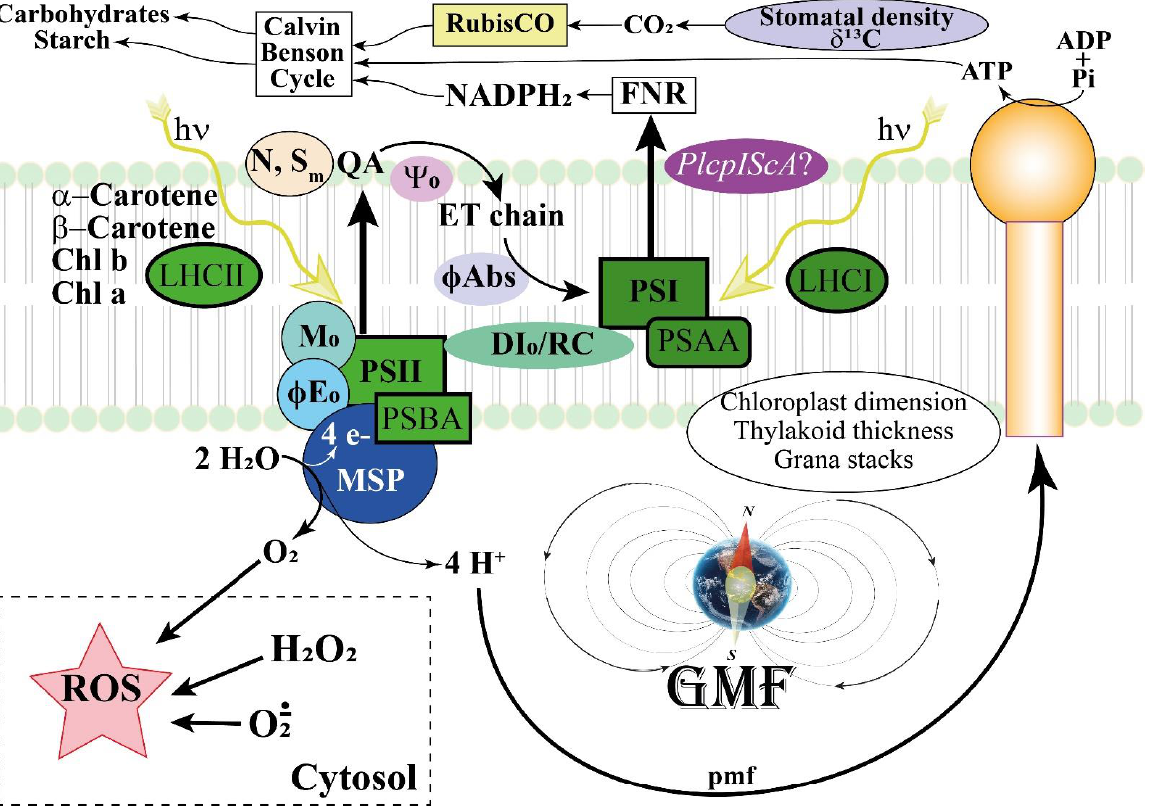
Figure 13. General scheme depicting the interaction between the GMF and the photosynthetic re- sponses in Lima beans. The GMF regulates leaf area, stomatal density, and δ 13 C, which in turn influ- ence the CO 2 availability for RubisCO and the production of carbohydrates and chloroplast starch. Chloroplast dimension and thylakoid structure are also regulated by the GMF to maintain the correct number of grana stacks and thylakoid thickness. The content of photosynthetic pigments including Chl a and Chl b, the main carotenoids and the light harvesting complexes LHCI and LHCII are regu- lated by the GMF, whereas the pmf is less affected by MF variations. On the other hand, a regulation occurs for PSAA and PSBA, which are associated with Photosystem I and II, respectively. In GMF conditions, electrons from the plastoquinone A (QA) are preferentially transferred to the ET chain (S m ) and the number of times that the QA is reduced increases (N). The GMF favors the efficiency to move electrons further than QA (Ψ 0 ), with a higher probability that a photon may move an electron into the ET chain (ϕE 0 ≡ ET 0 /ABS) and to directly move electrons in the ET chain (ϕAbs). Moreover, the GMF favors a higher dissipation of interactive reactions centers (DI 0 /RC). The GMF upregulates the expres- sion of Iron Sulfur Complex Assembly homologs of the magnetoreceptor gene MagR , with particular reference to PlcpIScA . This activity is correlated to the increased production of ROS, including H 2 O 2 and other peroxides, which depend on the modulation of ROS producing and ROS scavenging genes. Supplementary